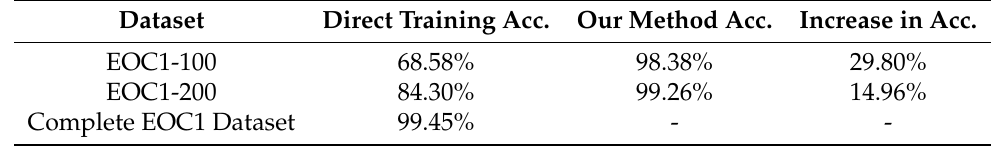
Table 6. EOC1 datasets experimental results.